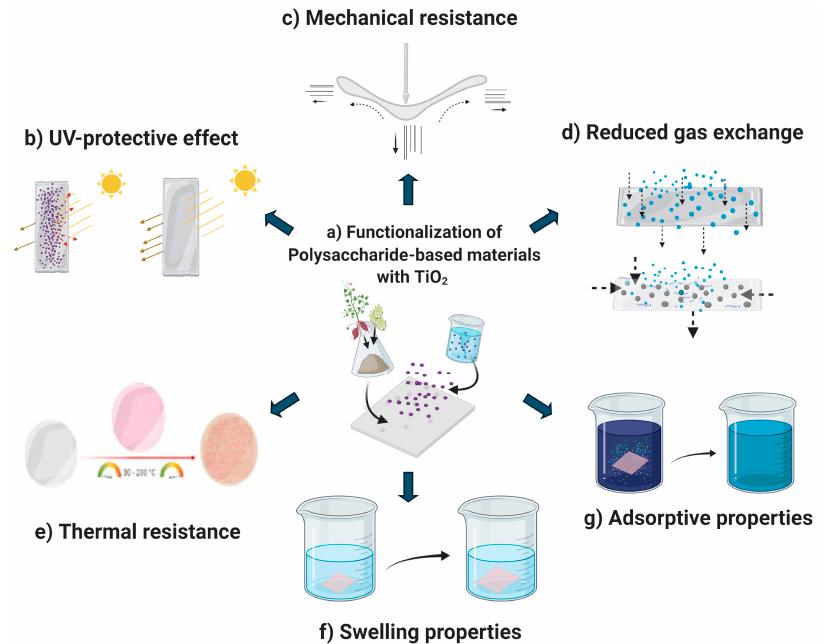
Figure 2. Schematic representation of the functionalization of polysaccharide-based materials with TiO 2 ( a ) and their e ff ects on the UV-blocking ( b ), mechanical ( c ), gas exchange ( d ), thermal ( e ), swelling ( f ), and adsorptive ( g ) properties (adapted from Hou et al. [34], Goudarzi et al. [35], de Moura et al. [36], and Dai et al. [37]) (Figure created in Biorender.com).